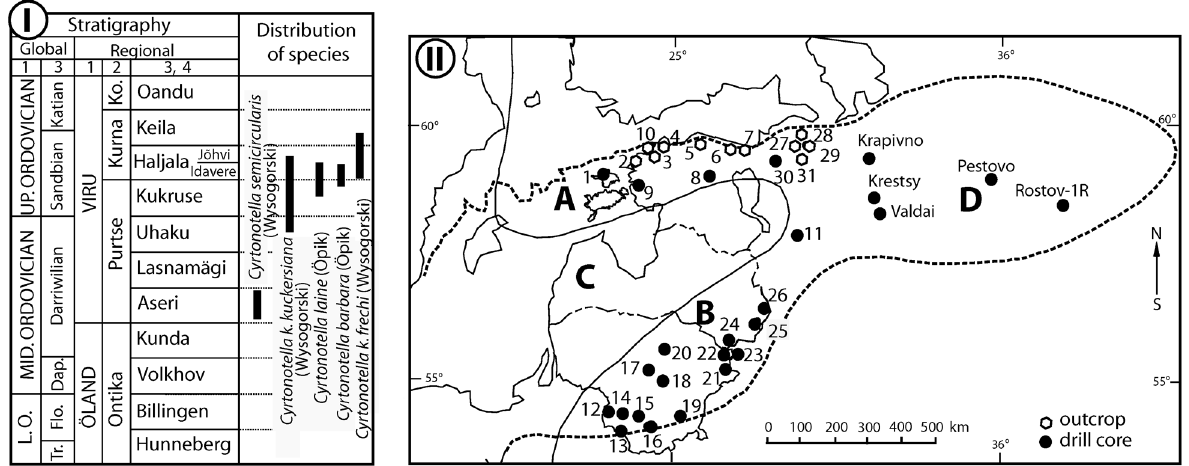
Fig. 6. Stratigraphical ( I ) and spatial ( II ) distribution of brachiopods of the genus Cyrtonotella (Schuchert & Cooper, 1931) in the Baltic Basin with the Estonian (A) and Lithuanian (B) shelves, Livonian Basin (C) and Moscow Basin (D). Explanations of the stratigraphic scheme : 1, global or regional series; 2, regional subseries; 3, global or regional stage; 4, regional sub- stage. Abbreviations : L.O., Lower Ordovician; Mid., Middle; Up., Upper; Tr., Tremadocian; Flo., Floian; Vi.,